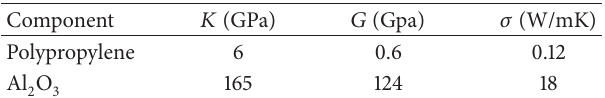
Figure 14: Volume fraction of pores (circles) and ALD layer (squares) of Al 2 O 3 coated polypropylene. Experimental data points taken from [15]. Curves calculated using formula (36). Table3:Propertiesofthestructuralcomponentsusedfortheatomic layer deposition process.